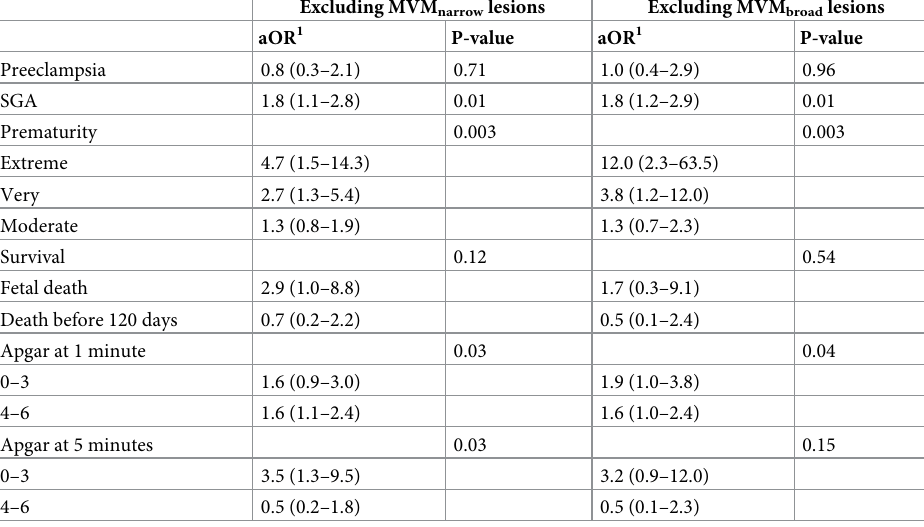
Table 7. Associations of previous spontaneous abortions and pregnancy outcomes excluding cases with MVM